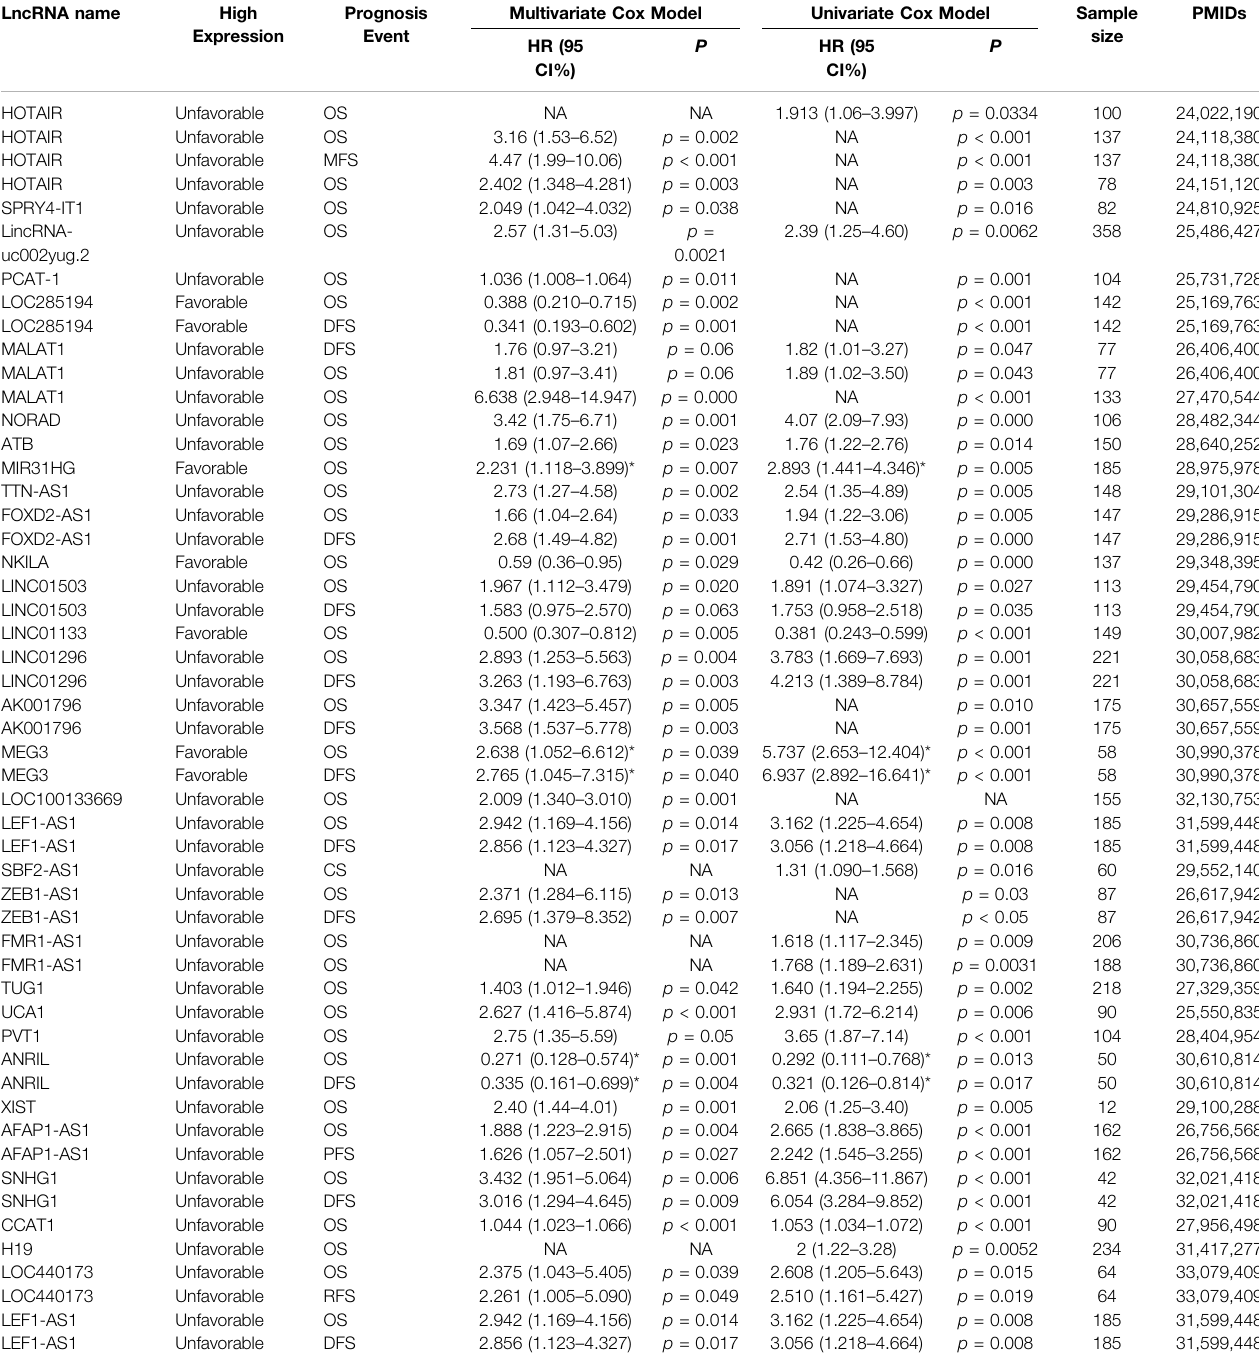
TABLE 4 | EC-associated prognosis